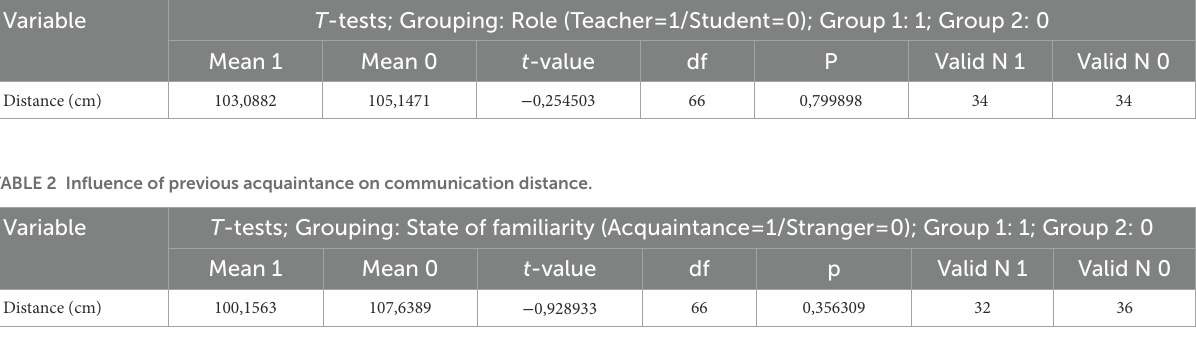
TABLE 1 Influence of status on communication distance.